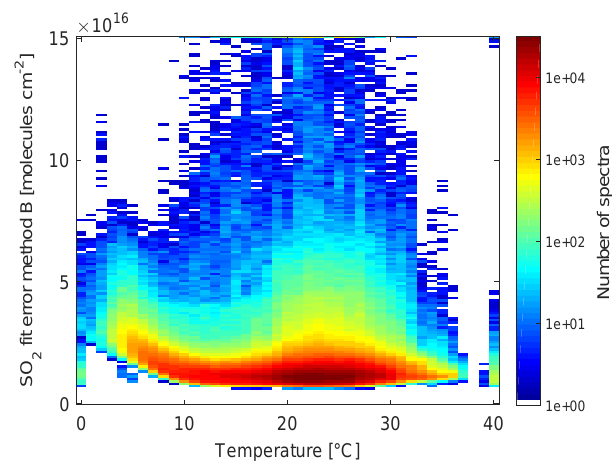
Figure 13. Two-dimensional histogram of the SO 2 DOAS fit error from the solar atlas evaluation as a function of instrument tempera- ture for instrument D2J2201.